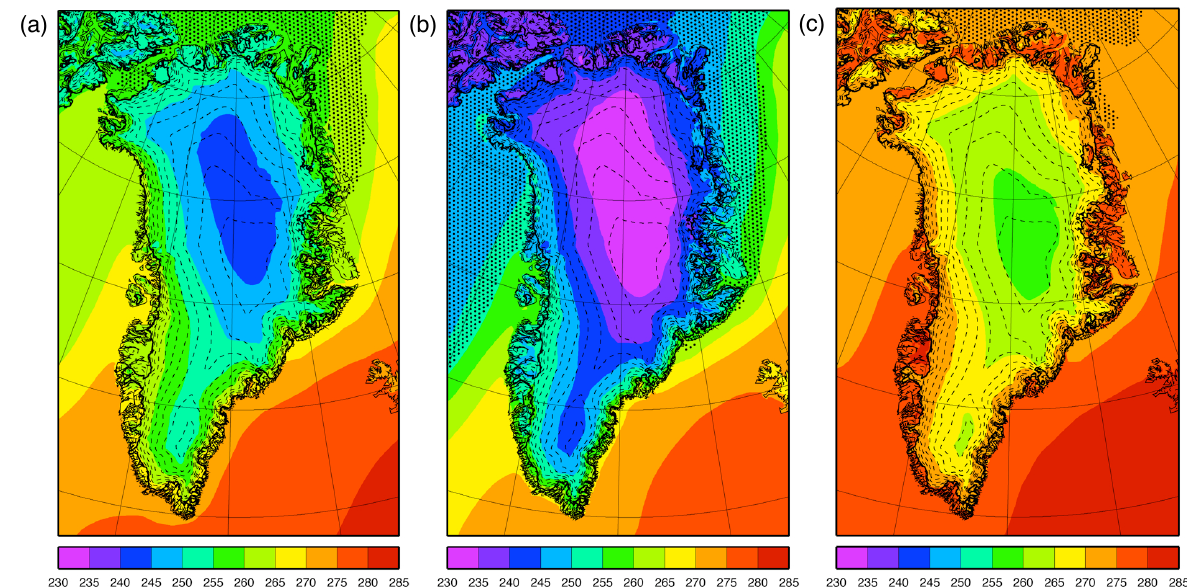
Fig. 4. Averaged 2m temperature (colour contours, [K]) and sea ice extent (shaded) over (a) a year, and the seasons (b) DJF and (c) JJA.